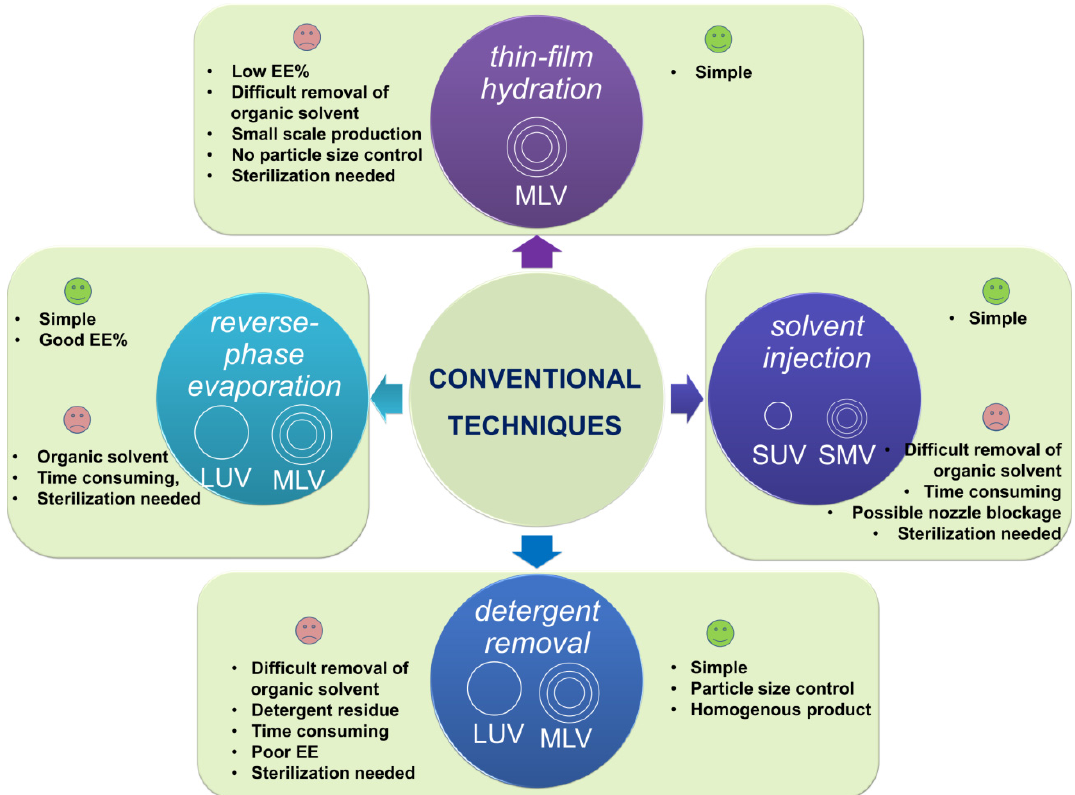
Figure 7. Main conventional techniques used for liposome preparation.